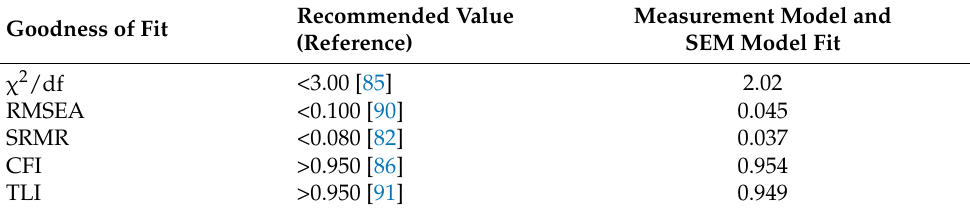
Measurement Model and SEM Model Fit